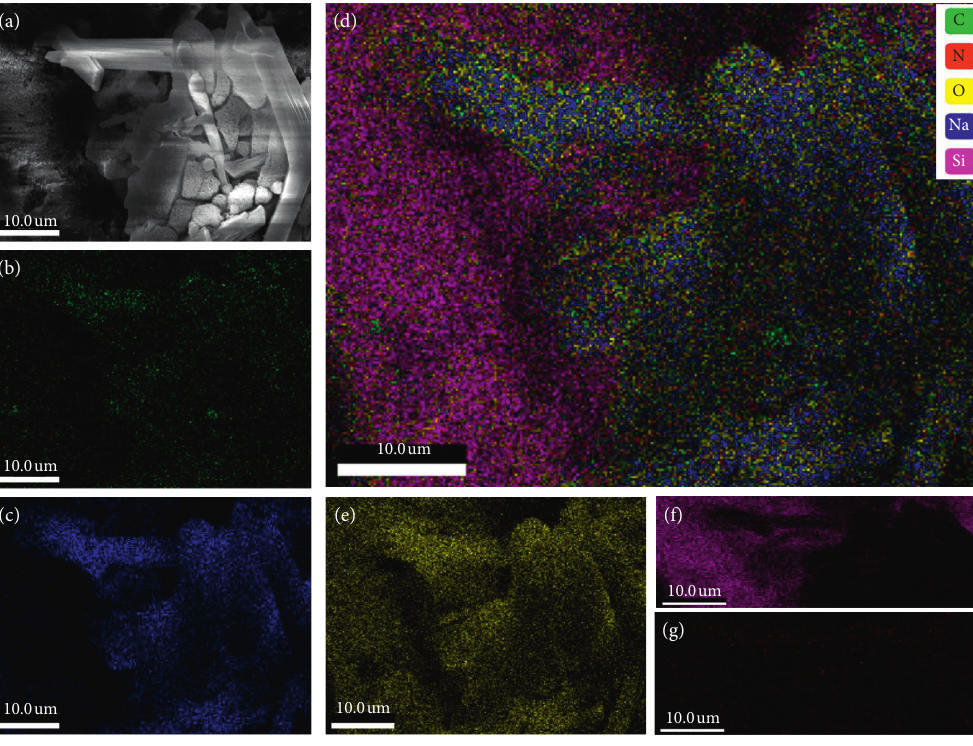
Figure 10: Element distribution of the C14-1%